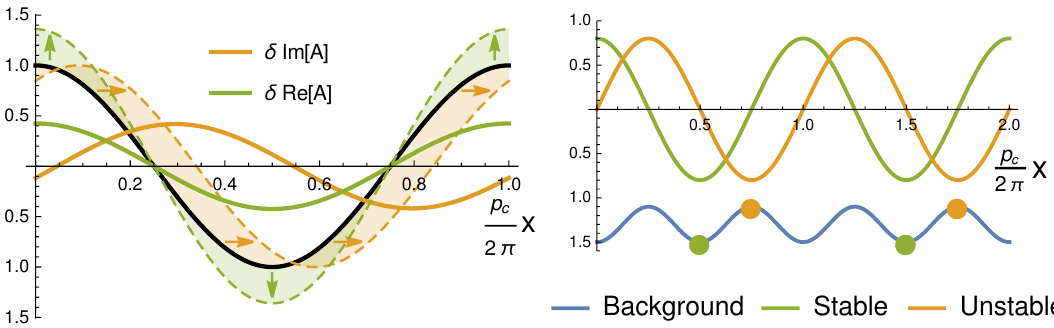
Figure 2. Left panel. Amplitude and phase modes in case of translation breaking due to periodic spontaneous structure. Black line is the order parameter. Shifts along the x -axis correspond to imaginary part of amplitude A (2.14), yellow line, variation of amplitude corresponds to real part, green line. Right panel. Stable and unstable ground states, in presence of explicit symmetry breaking potential (blue line). The two states are shifted by a quarter period. Minima of the stable state (purely real A ) correspond to minima of the explicit potential, while the minima of the unstable state (purely imaginary A ), to the